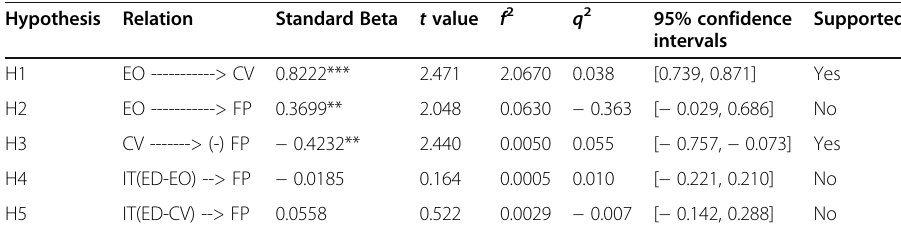
Table 9 Hypothesis testing